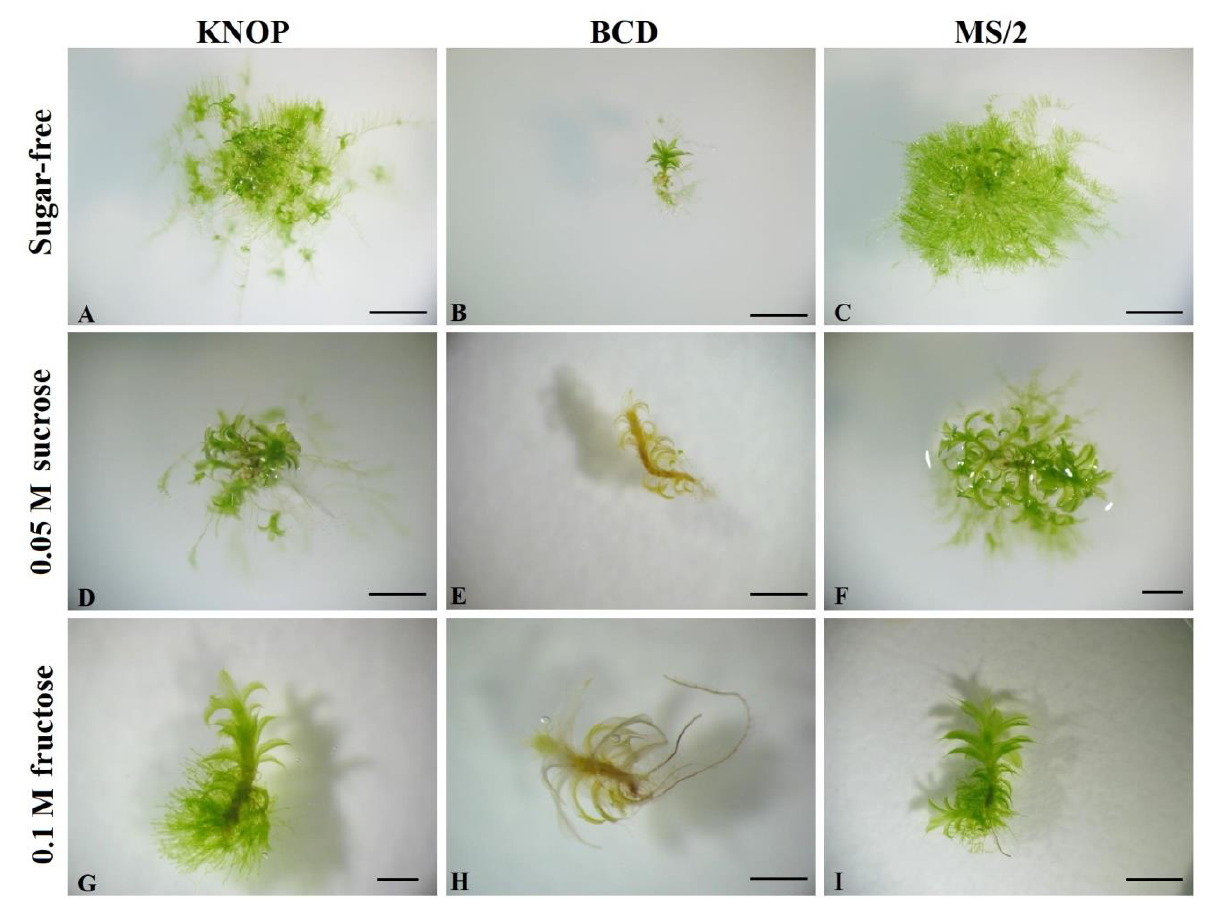
Figure 2. The appearance of Pterygoneurum sibiricum explants grown on different sugar-free nutri- ent media ( A – C ) and supplemented with sucrose ( D – F ) and fructose ( G – I ) in Experiment type ( I ). The bars represent size (( A – E , H , I ) 4 mm; ( F , G ) 2 mm).